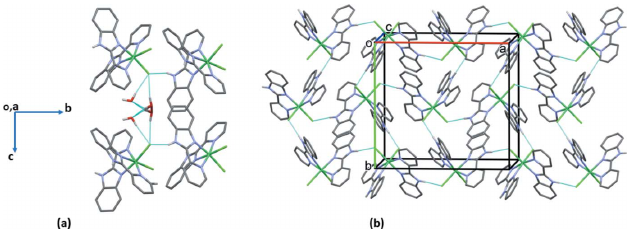
Figure 2 Hydrogen-bonding networks involving, ( a ) the discorded water molecule,